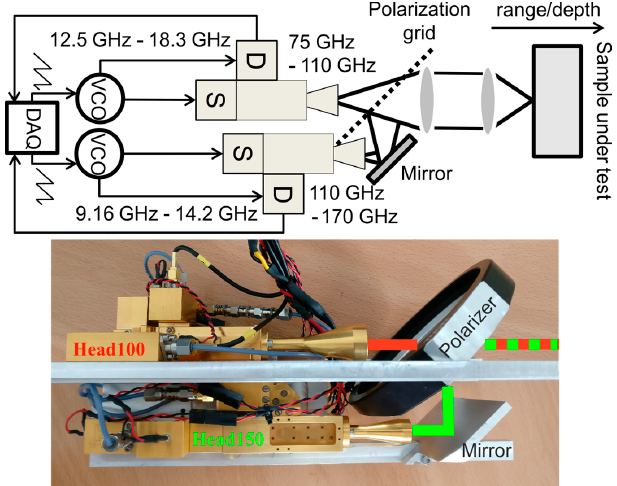
Figure 3. Schematic ( top ) and photograph ( bottom ) of the two-frequency terahertz measurement head combining the two sensor units working at adjacent frequency ranges from 70 to 110 and from 110 to 170 GHz. The fundamental oscillations are generated by two voltage controlled oscillators (VCOs) and multiplied to the target frequencies. A polarization wire grid is employed to overlay the two output signals, which are then focused onto the radome. Images are recorded in reflection geometry.